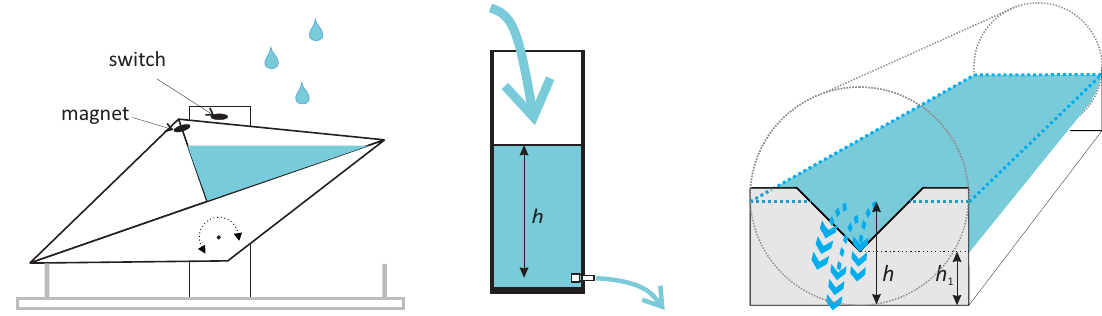
Fig. 3. From left to right: tipping bucket, danaide with one outlet, V-shaped weir; h is the actually measured